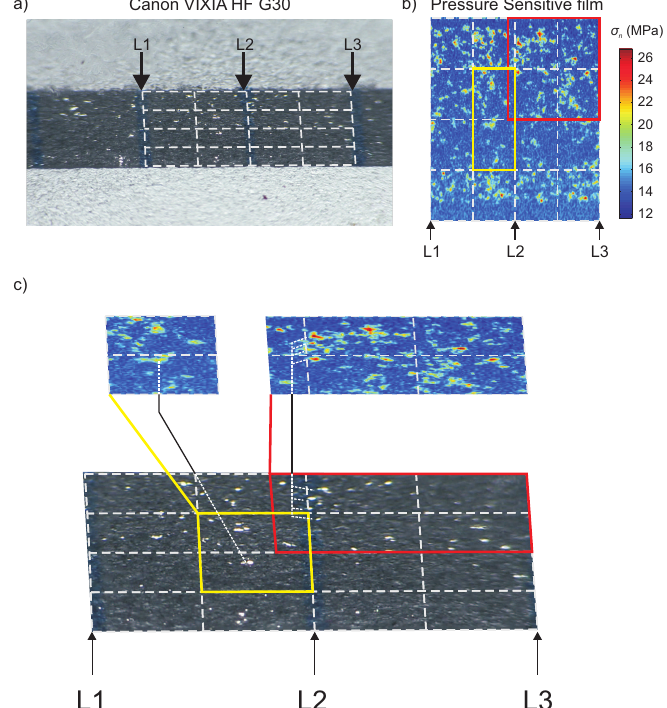
Figure 8. ( a ) A still frame obtained from the camcorder at one loading step. A grid was superimposed and followed the lines physically drawn on the interface. The lines L1, L2 and L3 were used for reference; ( b ) Results from the pressure-sensitive film (converted to stress) in the same location as in (a). Reference lines L1, L2 and L3 are shown. ( c ) The pressure-sensitive film was distorted using COREL DRAW to match the transformed coordinate system in the photograph (top). In the highlighted boxes, we see that the pressure measurements and the light transmitted occur at similar locations along the grid (connecting